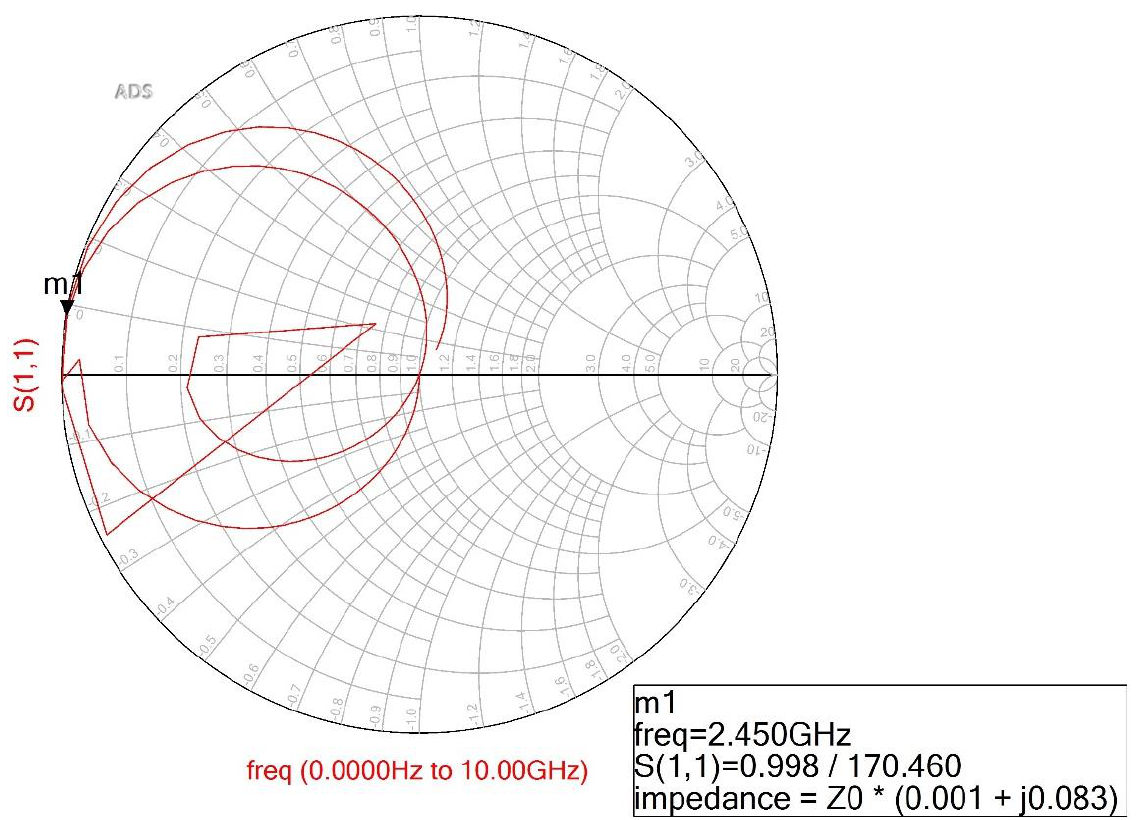
Figure 5. Simulation result for real and imaginary impedances for the proposed BPF.